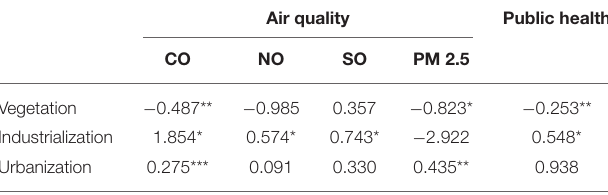
TABLE 4 | Regression